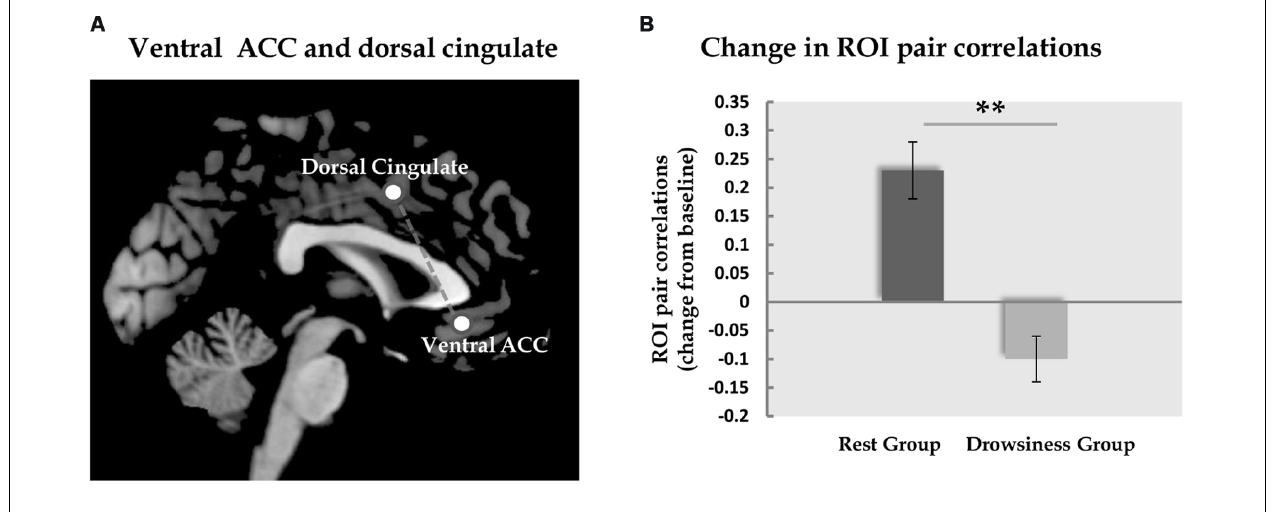
the 15-minute rest scan. In the “rest” group, but not in the “drowsiness” group, a significant rise in correlation was found. Dark column represents the “rest” group; light column represents the “drowsiness” group. ** q < 0.01.